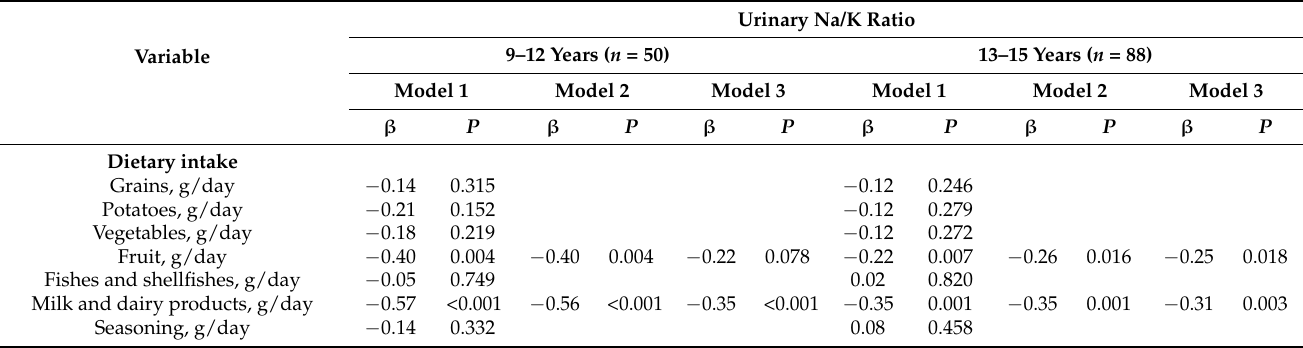
Table 6. Associations between dietary intake and the urinary Na/K ratio by age group.